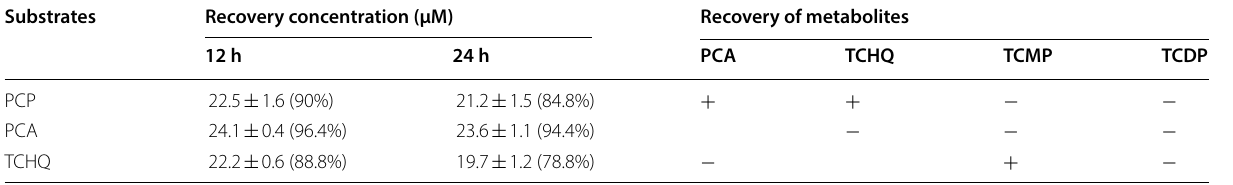
The initial concentration of all substrates was 25 μM. Values are mean